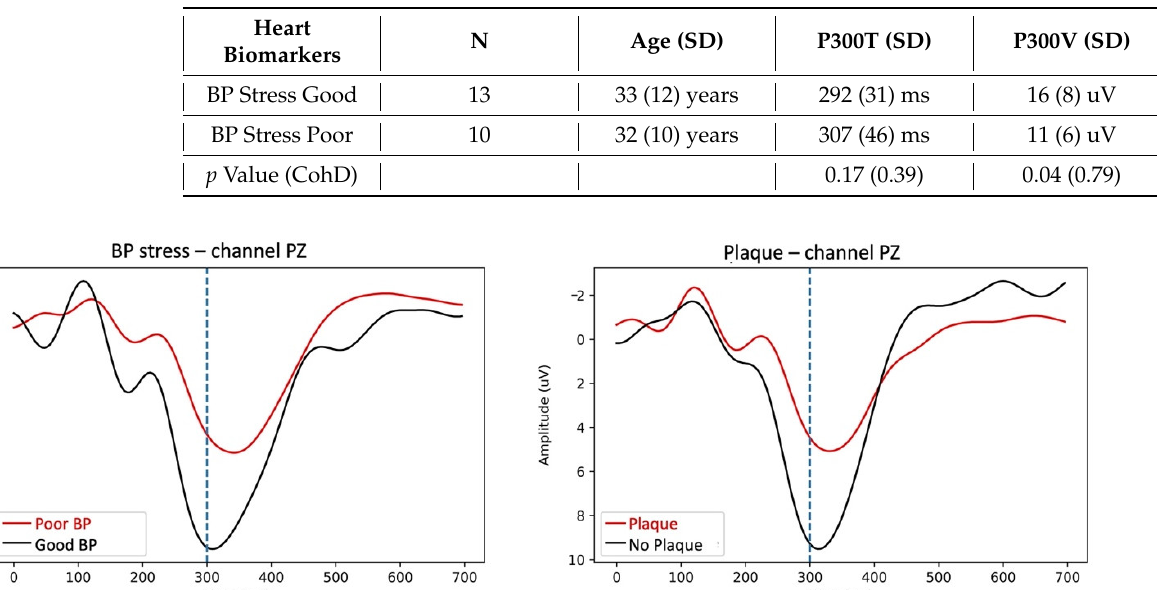
Figure 6. Evoked responses at Pz for good and poor levels of blood pressure ( left ) and plaque ( right ) averaged for all patients in this study younger than 55 years. Red curves represent poor levels and black represent good. Note that the trends of Figures 1 and 2 remain where poor cardio health cor- responds to low P300 performance even for this younger population.